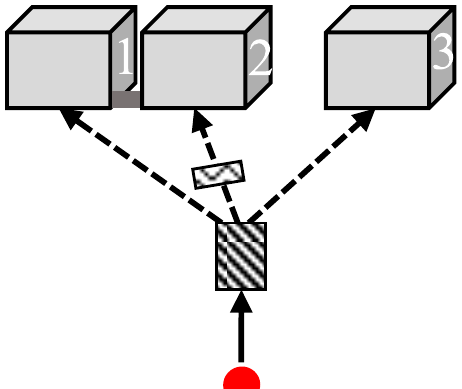
Figure 1. The preparation (Measurement A). A three-port beam-splitter splits the wavefunction into three parts proceeding towards the three boxes. The narrow passage connecting Boxes 1 and 2 enables tunneling between them. A phase shifter adds a phase of -i to the wavepacket in Box